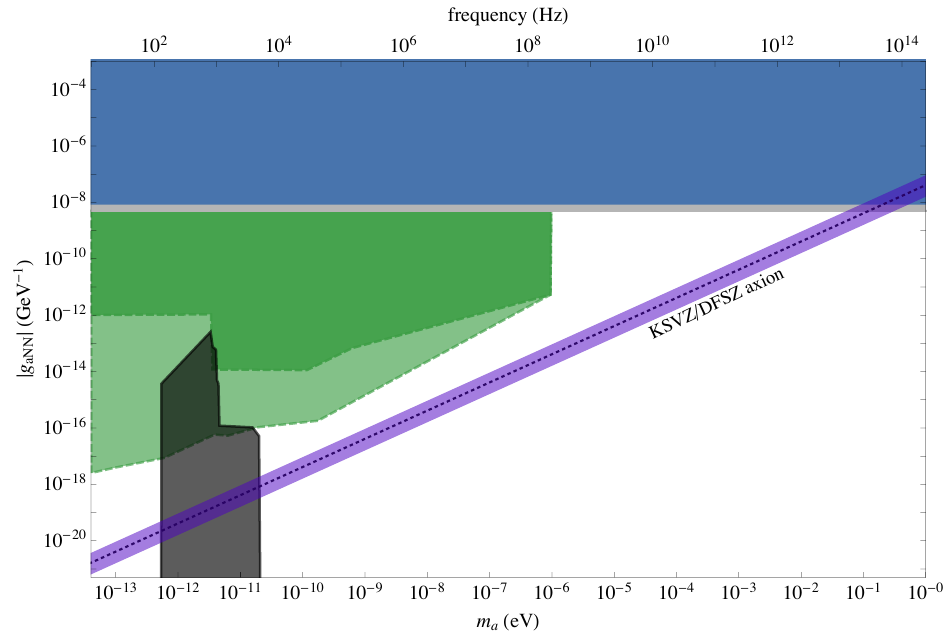
Figure 1 . Current and future bounds on the axion-nucleon coupling. Regions bounded by solid lines are existing constraints from the branching ratio of K ! (cid:25)a (blue) (with j c 12 j = 1 and (cid:15) = 0 : 02), SN1987A [31] (grey) , and black hole superradiance [32] (black) . The darker green region will be probed by CASPEr-Wind [18], and the lighter green region shows its ultimate theoretical reach [17]. The KSVZ axion line is shown in black (dotted), while the DFSZ axion band is shown in purple. The axion-nucleon coupling has the standard relation for these axions: g aNN (cid:24) 1 =f a (cid:24) m a = (cid:3) 2 be concrete, we have plotted the axion-proton coupling given in [33].) In our model, g aNN (cid:24) 1 =f , where f can be an arbitrary value, allowing g aNN to be parametrically